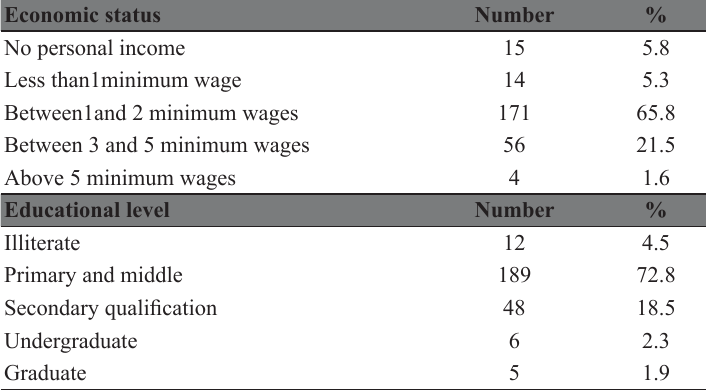
economic status and educational level of C. uniflora